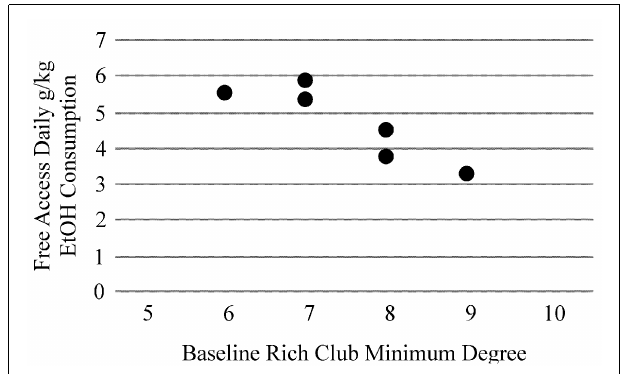
FIGURE 1 | The minimum degree of the Rich Club of the alcohol naïve (Baseline) functional brain network was strongly related to future drinking when animals were provided free-access to alcohol ( r = − 0.88, p = 0.02).